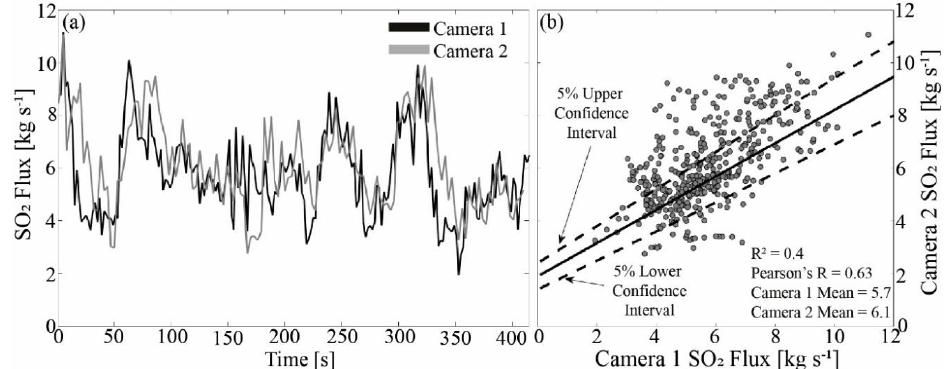
Figure 5. ( a ) Example period of overlapping data from two separately acquiring synchronous cameras, which viewed the plume from slightly different orientations. One dataset has been shifted by the lag value, which generated the maximum correlation coefficient, following the cross-correlation between the two series in an attempt to best temporally match the data. Note that there are differences in the magnitudes of peaks and troughs in the different data series, even when shifted relative to one another in this way, due to smoothing or turbulence during plume movement through the atmosphere and the slightly different views of the units through the plume. ( b ) A linear regression model (R 2 = 0.4) is shown, demonstrating the best fit between time series data from the two cameras, as well as confidence intervals. The statistical parameters are similar, but there are differences in peaks and troughs between the two datasets. Remote Sens. 2020 , 12 , x FOR PEER REVIEW